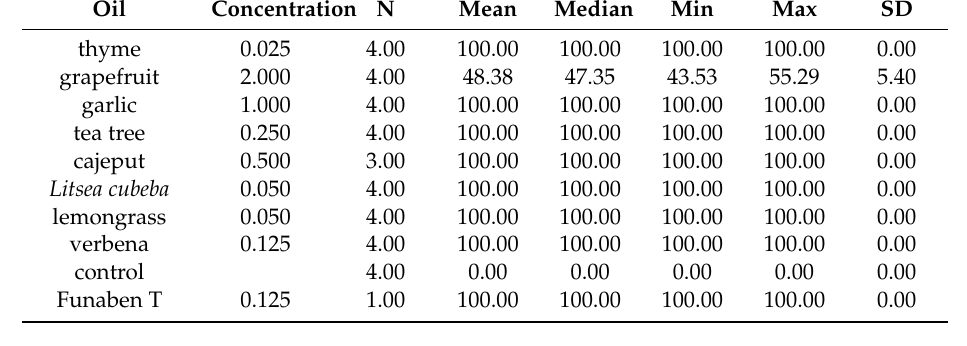
Table 6. Maximum fungistatic activity of the analyzed oils at minimum concentration for the isolate of F. graminearum .